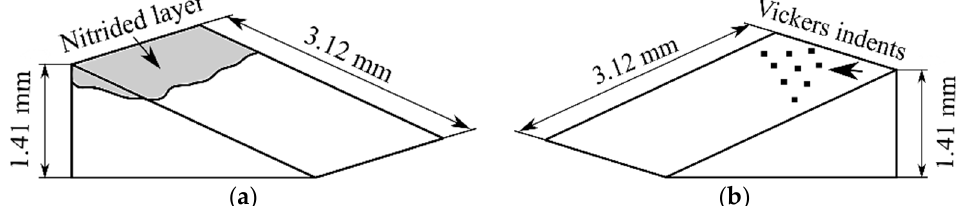
Figure 3. Schematic of the method of sample preparation for microstructural studies ( a ) and micro- hardness tests ( b ). hardness tests ( b